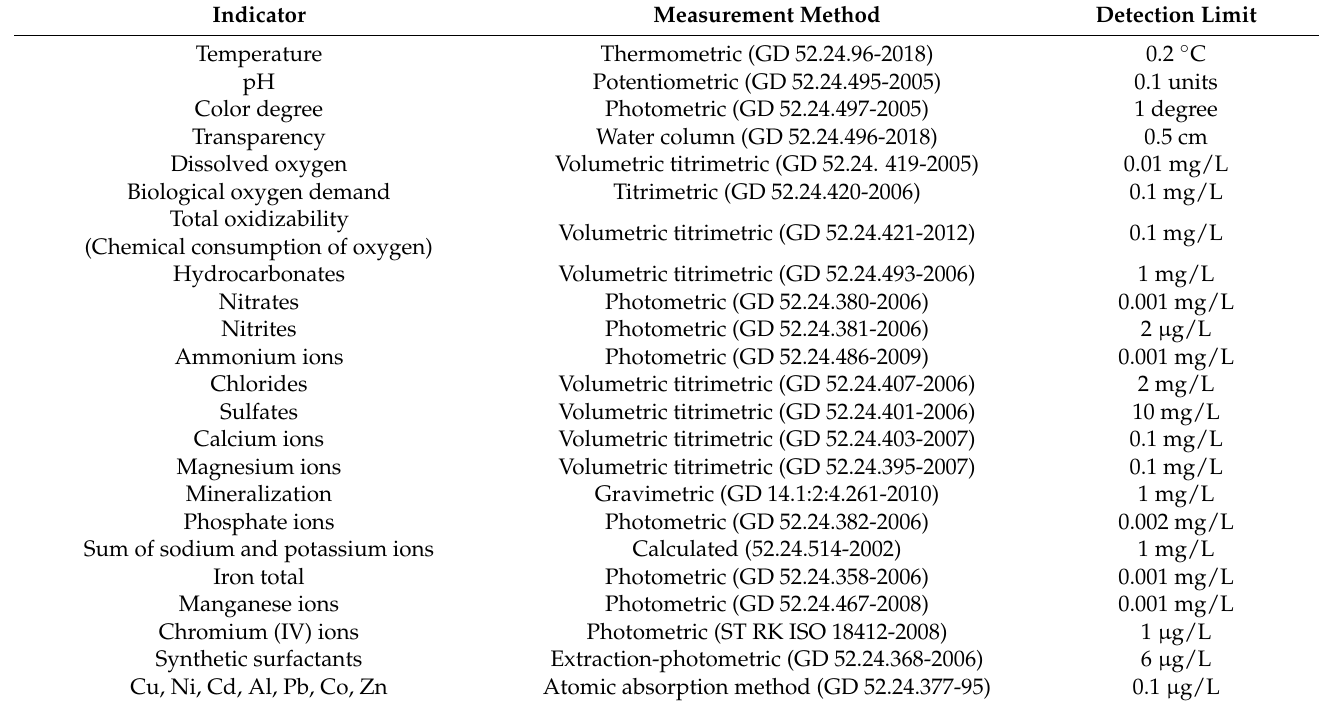
Table 2. Main measured water quality indicators, methods for their determination and detection limits. Measurement